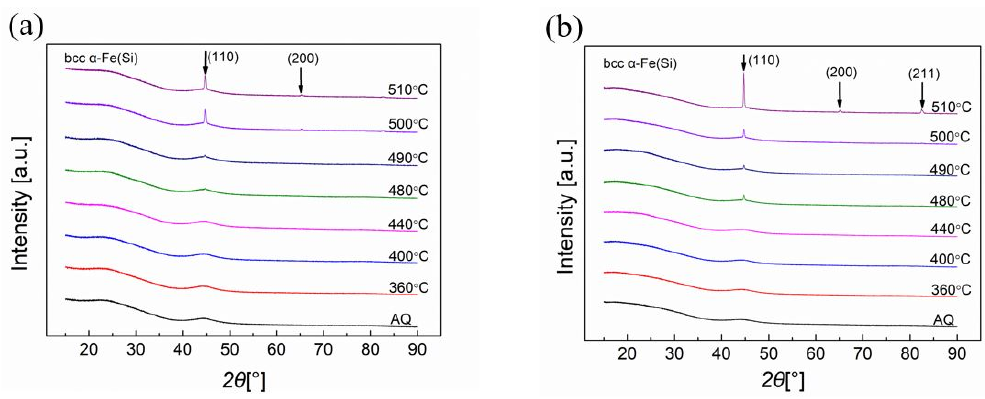
Figure 4. ( a ) The average value of the magnetomechanical coupling factors of Metglas 2605SA1 rib- bons, k, as a function of the bias field, H dc . Black, red, green, blue, cyan, magenta, yellow, dark yel- low, and navy curves are annealed at 350 °C, 370 °C, 390 °C, 410 °C, 440 °C, 470 °C, 490 °C, 500 °C, and 510 °C for 20 min, respectively. ( b ) The average value of the quality factors of Metglas ribbons, Q, as a function of the bias field, H dc . Black, red, green, blue, cyan, magenta, yellow, dark yellow, and navy curves are annealed at 350 °C, 370 °C, 390 °C, 410 °C, 440 °C, 470 °C, 490 °C, 500 °C, and 510 °C for 20 min, respectively. ( c ) The maximum value of coupling coefficient of Metglas ribbons, k, as a function of the annealing temperature, T. The green and red curves represent the values of the quality factors and efficiency coefficients corresponding to the maximum values of coupling